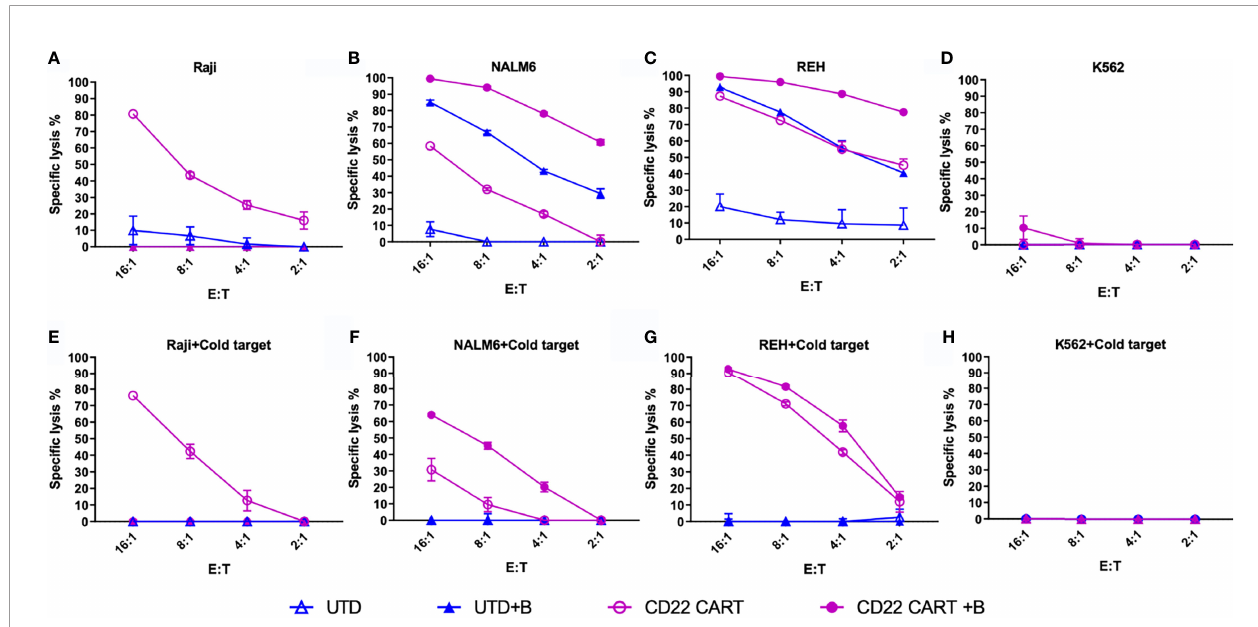
FIGURE 6 | Anti-CD22 CAR-T mediated cellular cytotoxicity (CTL) of bryostatin-treated leukemia. (A – D) Average lysis from triplicate wells for four cell lines (Raji, NALM6, REH, and K562) by anti-CD22 CART (CD22 CART, open circle) or un-transduced T cells from the same donor (UTD, open triangle), treated with bryostatin (+B, closed shape) or untreated (open shape), a the E:T ratios listed on the x-axis. (E – H) Assay tested in parallel including cold-target inhibition (addition of K562 at a 30:1 E:T ratio). Representative results for T cells from 3 donors are shown, each data point showing the average and standard deviation from three replicate